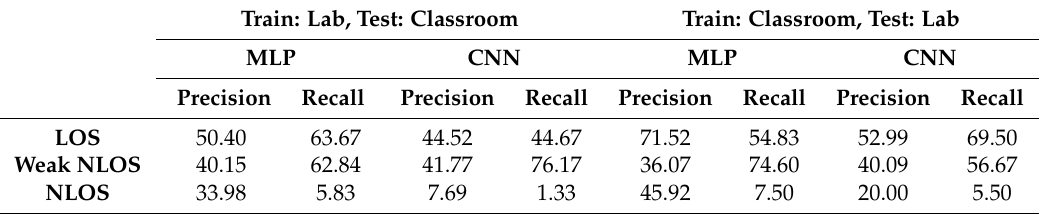
Figure 6. UWB channel classification accuracy of different training places and models. Table 4. UWBchannelclassificationperformanceoftheMLPandCNNindifferentunmeasuredenvironments.